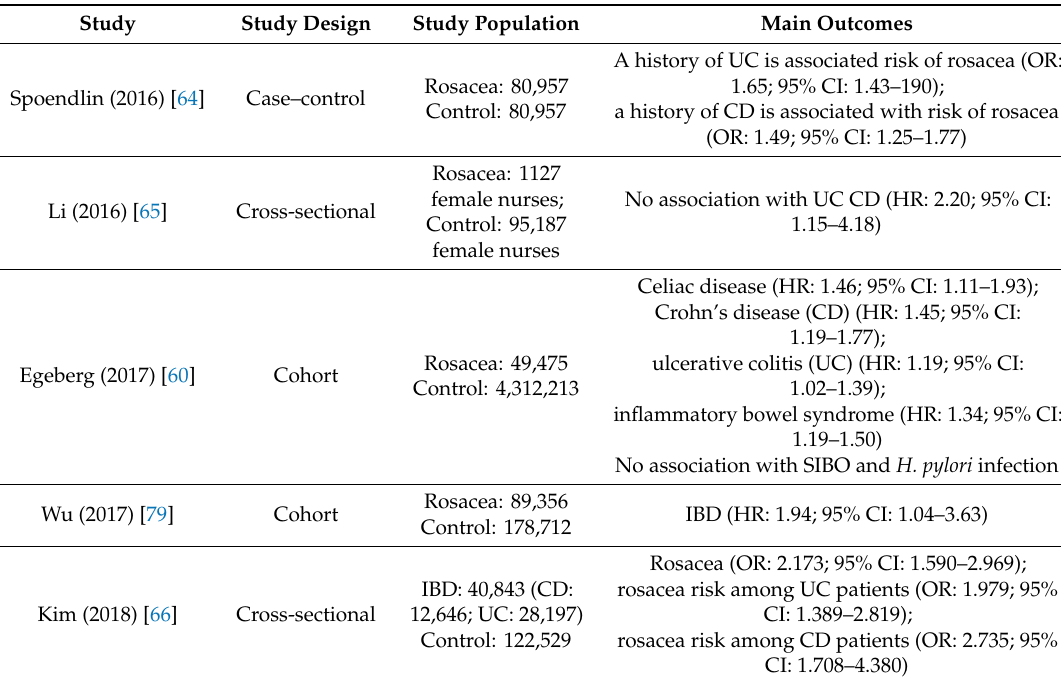
Table 2. Recent cohort, cross-sectional, and case–control studies (2010–2020) identifying an associated risk between inflammatory bowel disease and